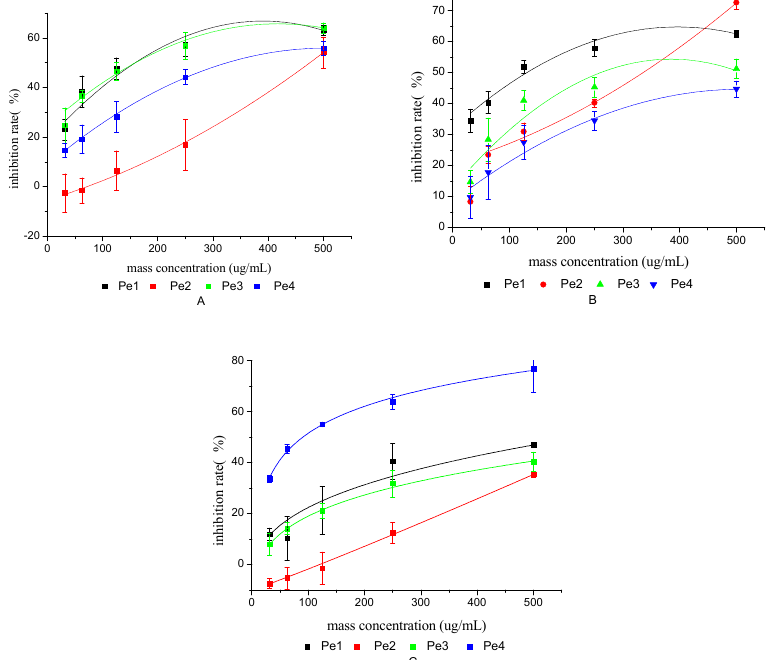
Figure 10. Results of antitumor activities of polysaccharides from TCBL against MCF7 cells ( A ), HepG2 cells ( B ), and Hela cells ( C ). Table 5. The IC 50 values of the antitumor activity of the four purified polysaccharides against the three types of cancer cells.